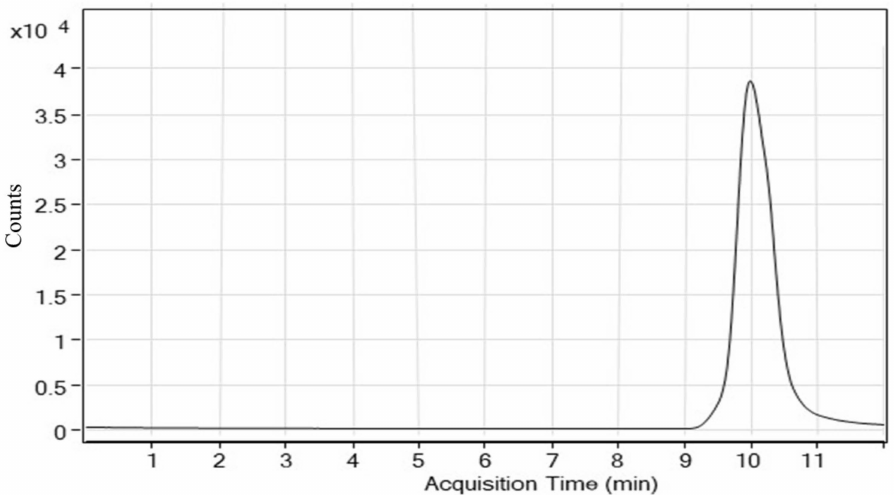
Figure 3. Sample chromatogram obtained after proper optimization at the mobile phase composition of ethanol: 0.1% formic acid